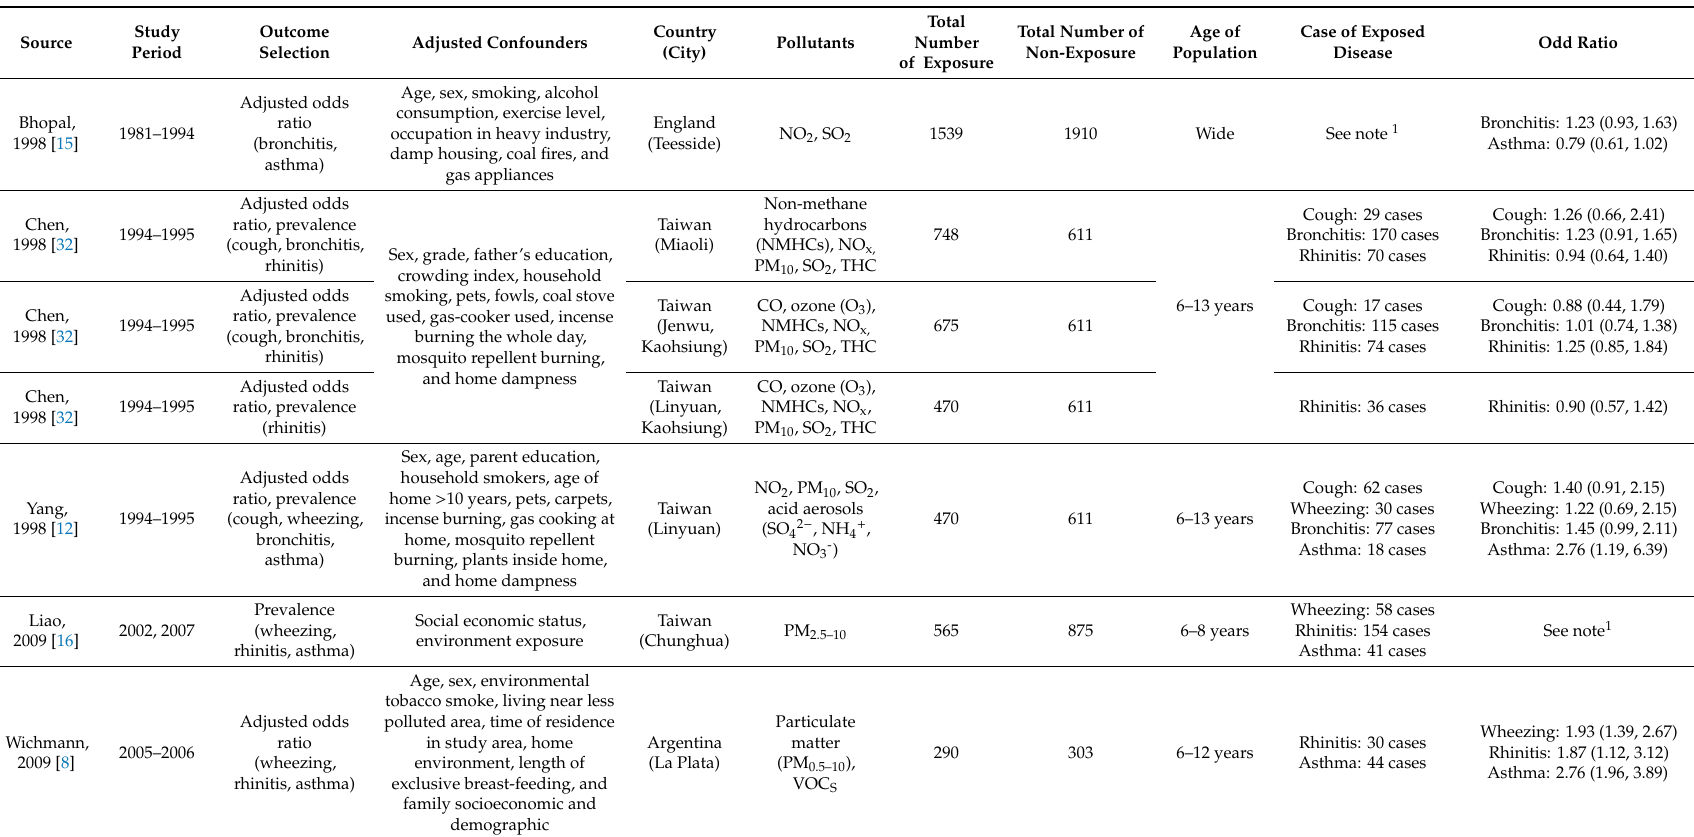
Table A1. Basic characteristics of the studies included in the